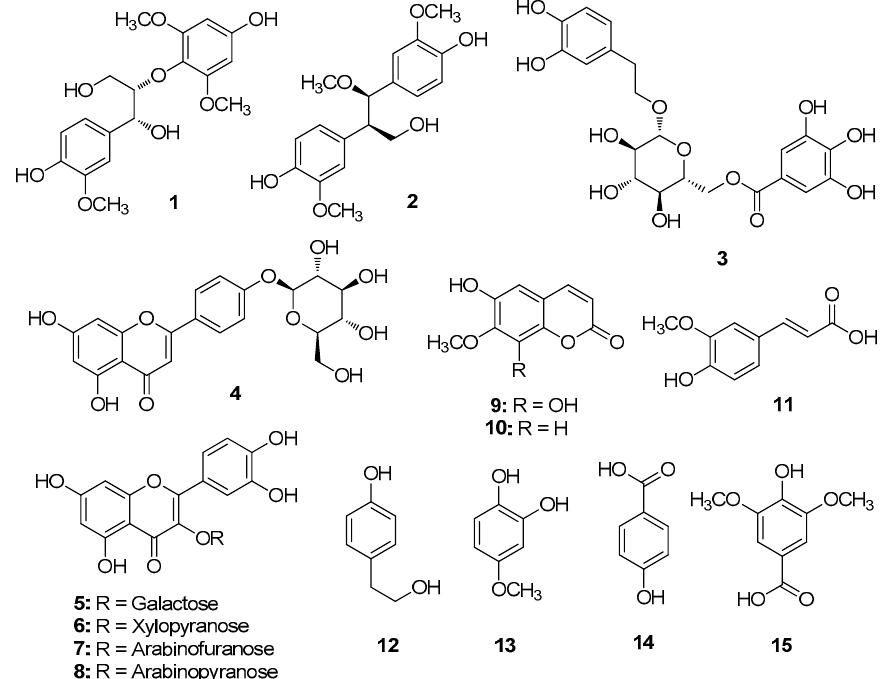
Figure 1. Chemical structures of compounds ( 1 – 15 ) isolated from A. tegmentosum bark.